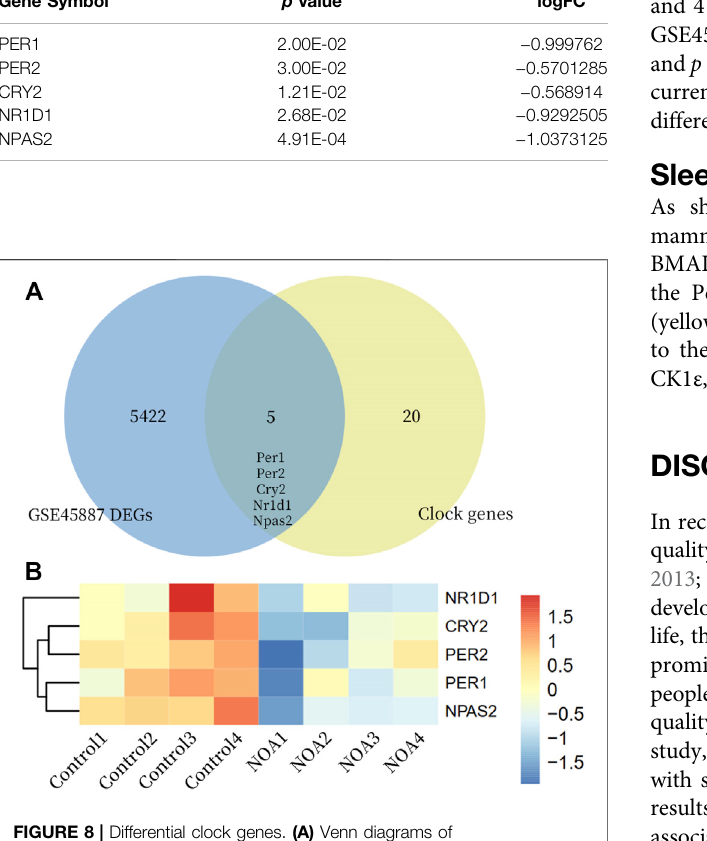
FIGURE 8 | Differential clock genes. (A) Venn diagrams of GSE45887 gene set intersecting clock genes; (B) Heat map of differential clock